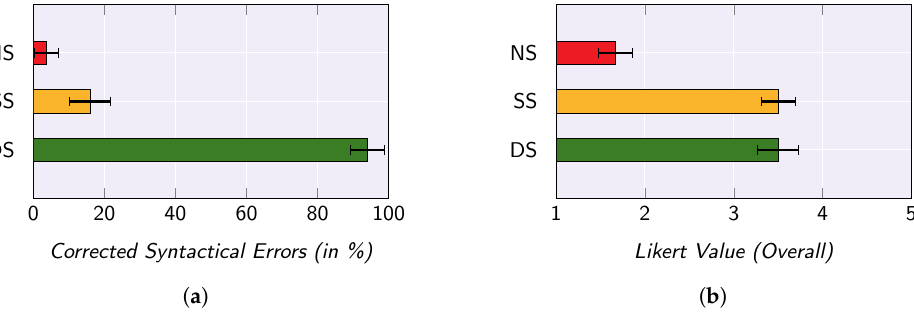
Figure 6. Key findings of the user study conducted by Behringer et al. [98]. ( a ) Mean percentage of cleaned data issues; ( b ) overall Satisfaction of the